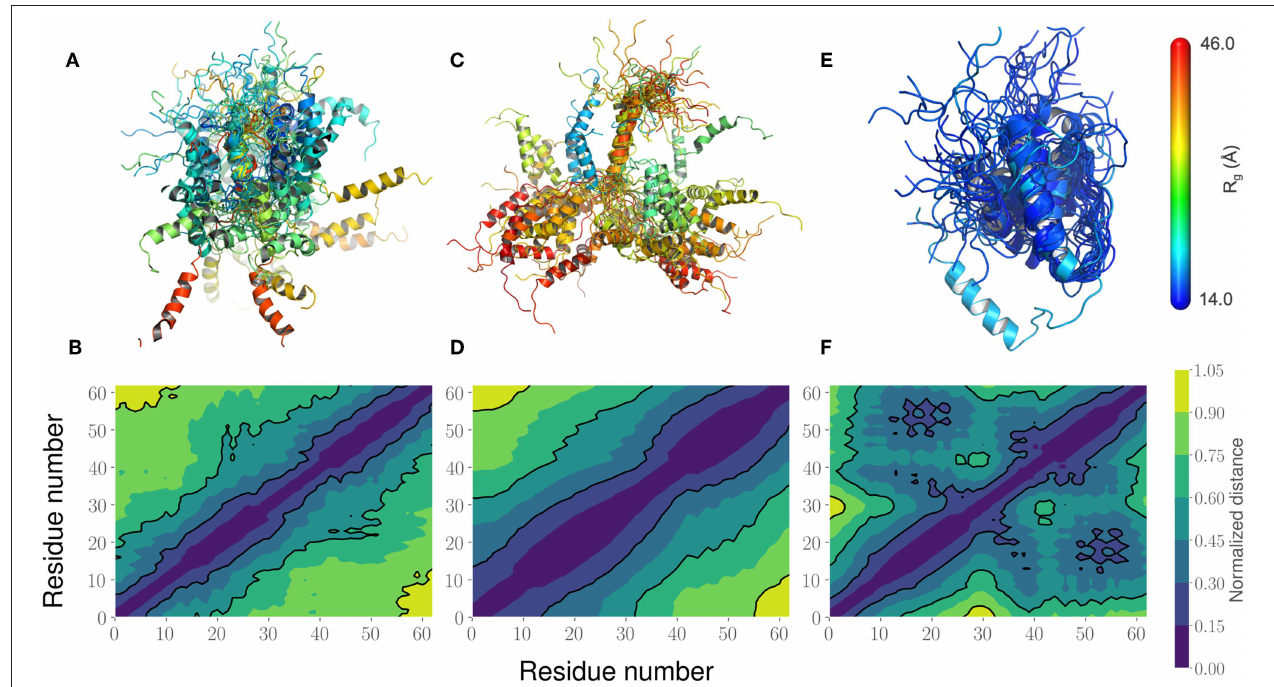
FIGURE 6 | Comparison of the PaaA2 Ensembles determined from experiments and simulations highlight regions of long-range interactions between the two α -helices. (A) A cartoon depiction of the PaaA2 ensemble determined using SAXS and NMR techniques using Flexible-Meccano. (B) Shows the normalized mean distance matrix showing the various interactions between residues; shades of blue indicate proximity in the chain—implying the increased likelihood of interactions. (C) Cartoon representation of the PaaA2 ensemble from the original FF along with the (D) normalized mean distance matrix. Note that many of the conformations are in the extended state—indicating less likelihood of interactions between the α -helices. (E) Cartoon representation from the PaaA2 ensemble from the optimized FF simulation along with the (F) normalized mean distance matrix. The conformations generated by the optimized FF are more compact than the other two datasets mainly because the sampling from the optimization runs are